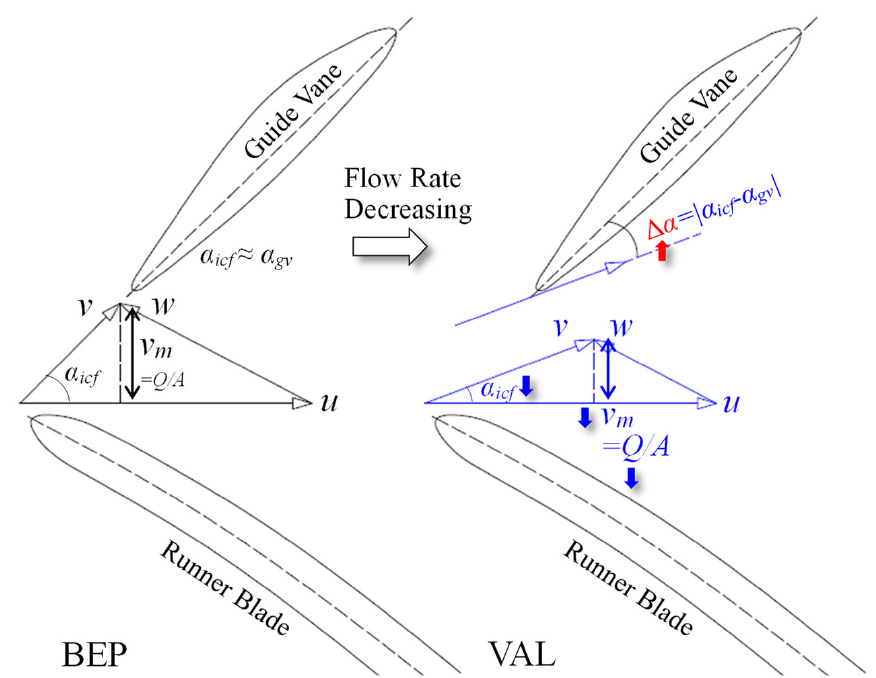
Figure 11. Schematic map of the mismatching of guide vane flow angle.